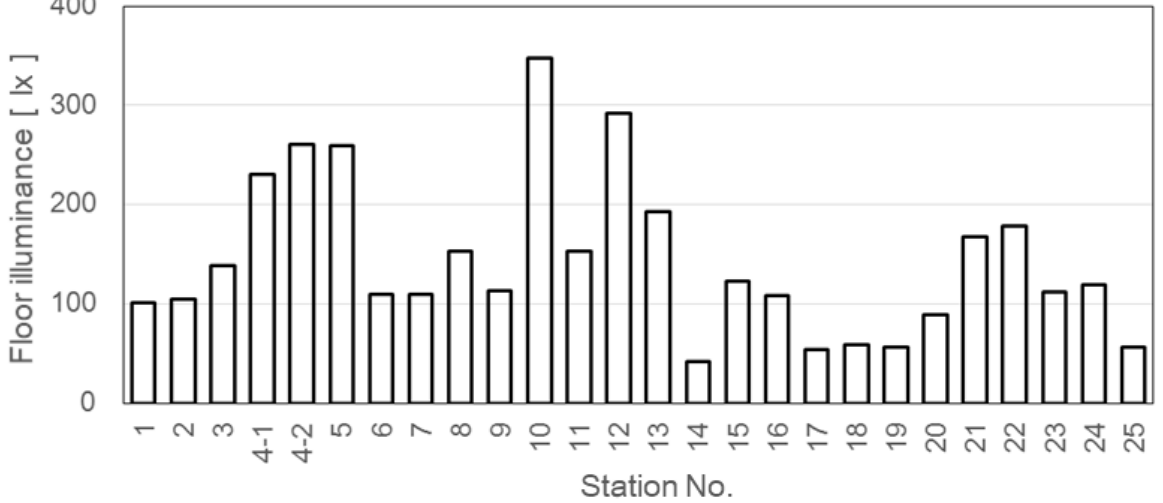
Figure 3. Measurement results of the floor illuminance of the platforms.